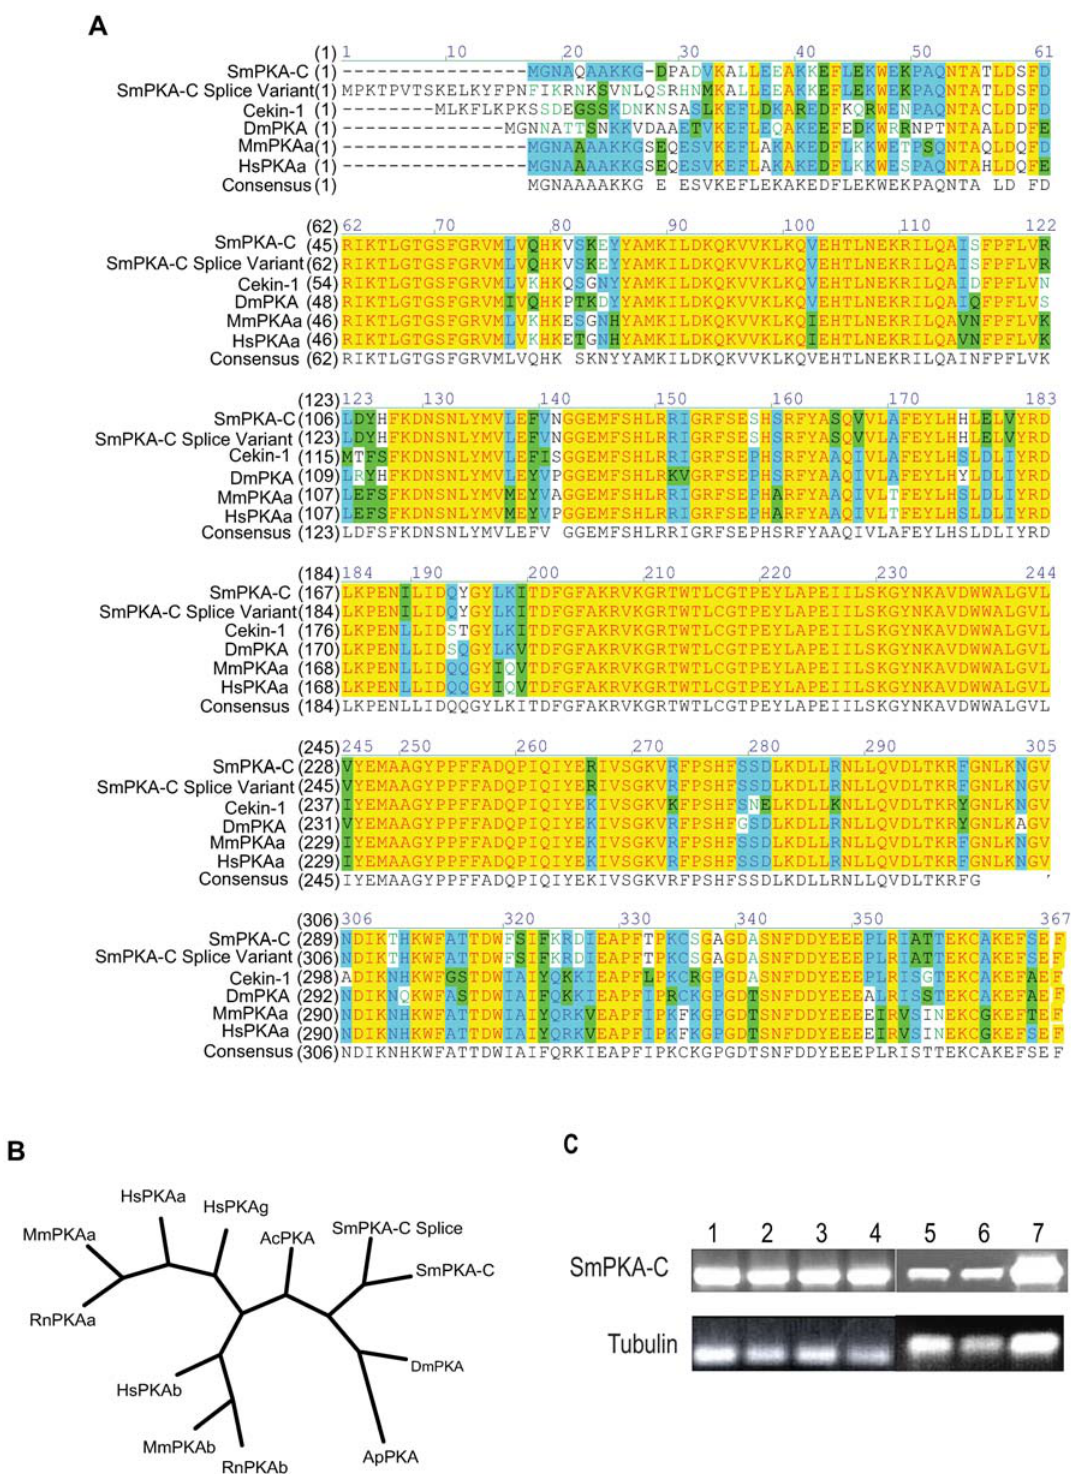
Figure 4. Identification of SmPKA-C as a PKA-C subunit from S.mansoni . A, Amino acid alignment of both SmPKA-C and putative splice variant peptide sequences with PKA-C sequences from Caenorhabditis elegans (Cekin-1; NP_493605), Drosophila melanogaster (DmPKA; NP_476977), Mus musculus (MmPKAa; P05132) and Homo sapiens (HsPKAa; P17612). B, Phylogenetic analysis comparing both SmPKA-C amino acid sequences to the following PKA-C sequences from other organisms: Homo sapiens PKA-C a (HsPKAa; P17612), H. sapiens PKA-C b (HsPKAb; P22694), H. sapiens PKA- C c (HsPKAg; P22612), Mus musculus PKA-C a (MmPKAa; P05132), M. musculus PKA-C b (MmPKAb; P68181), Rattus norvegicus PKA-C a (RnPKAa; P27791), R. norvegicus PKA-C b (RnPKAb; P68182), D. melanogaster (DmPKA; NP_476977), Aplysia californica (AcPKA; CAA45014), and Acyrthosiphon pisum (ApPKA; XP_001946114). C, SmPKA-C transcript is expressed in cDNA of all the life cycle stages of S. mansoni . 1, egg, 2, miracidium, 3, sporocyst, 4, cercaria, 5, schistosomulum, 6, adult female, 7, adult male.